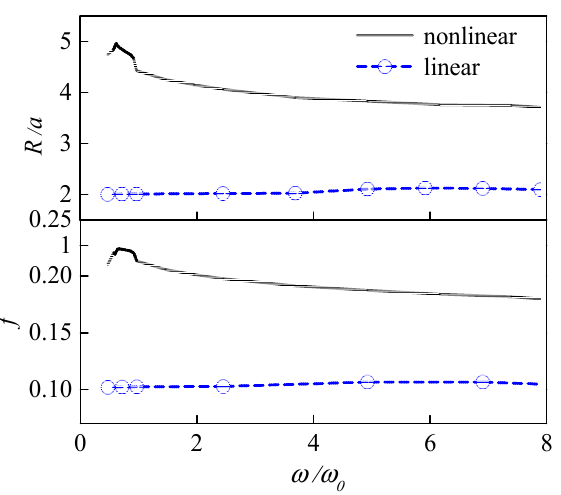
Figure 11. MWR along the vertical seawall and maximum wave force acting on the vertical seawall for double incident waves of different wave frequencies.